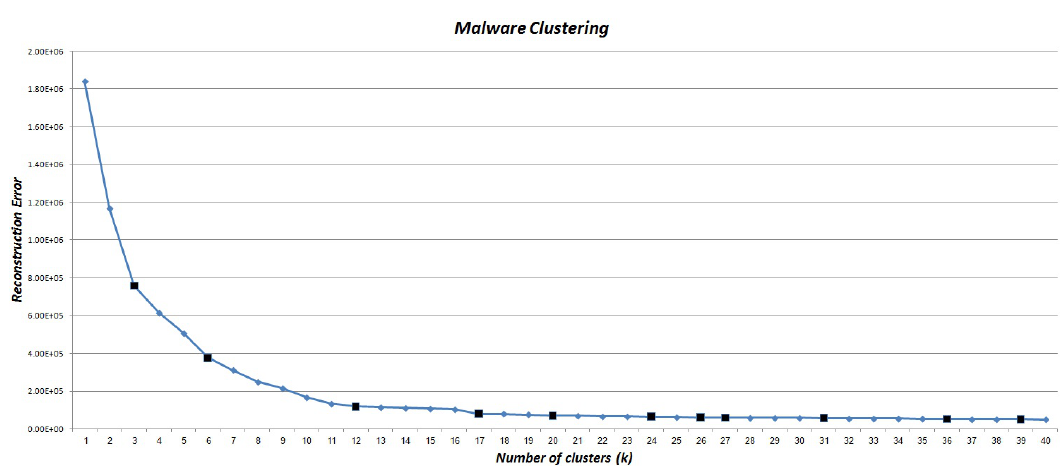
Figure 4. Variation of reconstruction error for different number of malware clusters. Black points shows candidate k